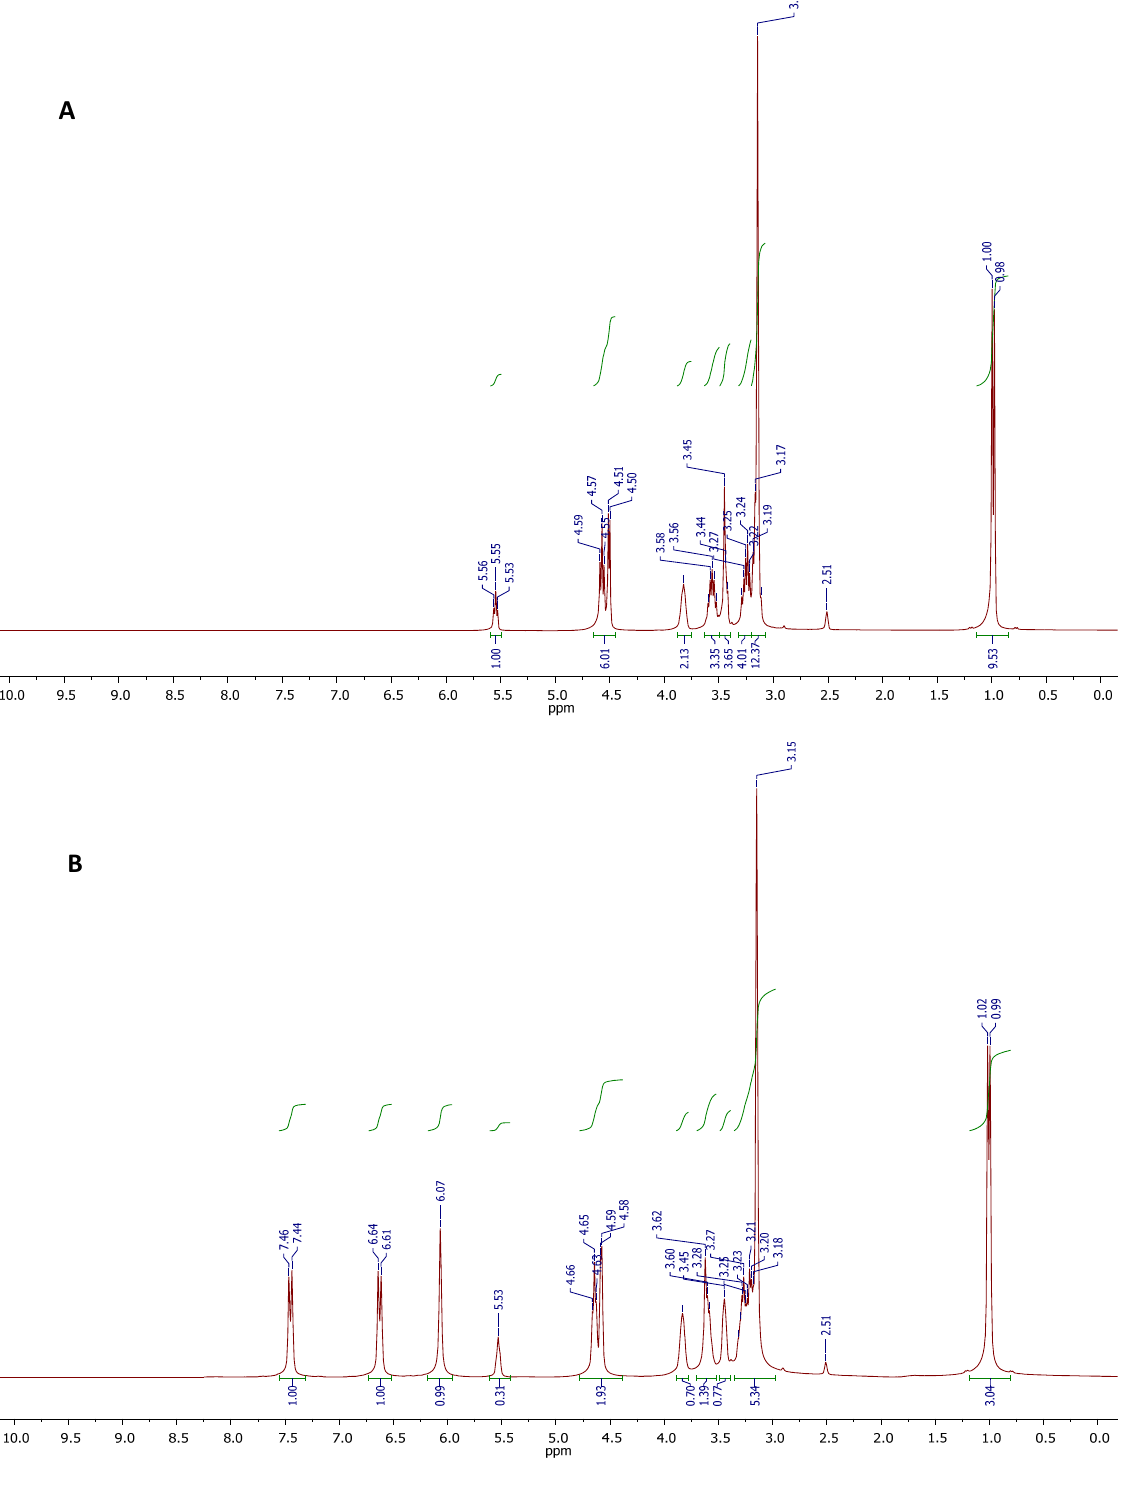
Figure 4. 1 H NMR spectra of the CC-PG DES ( A ), and DES-DAP ternary system ( B ). After DAP was loaded into CC-PG DES, all the active hydrogen signals of each component in the formed ternary mixture were clearly distinguishable and attributable (Figure 4, spectrum B). The spectral region between 5.75 and 7.75 ppm showed all signals attributable to the resonance of the DAP protons. The signals of all C-H protons in